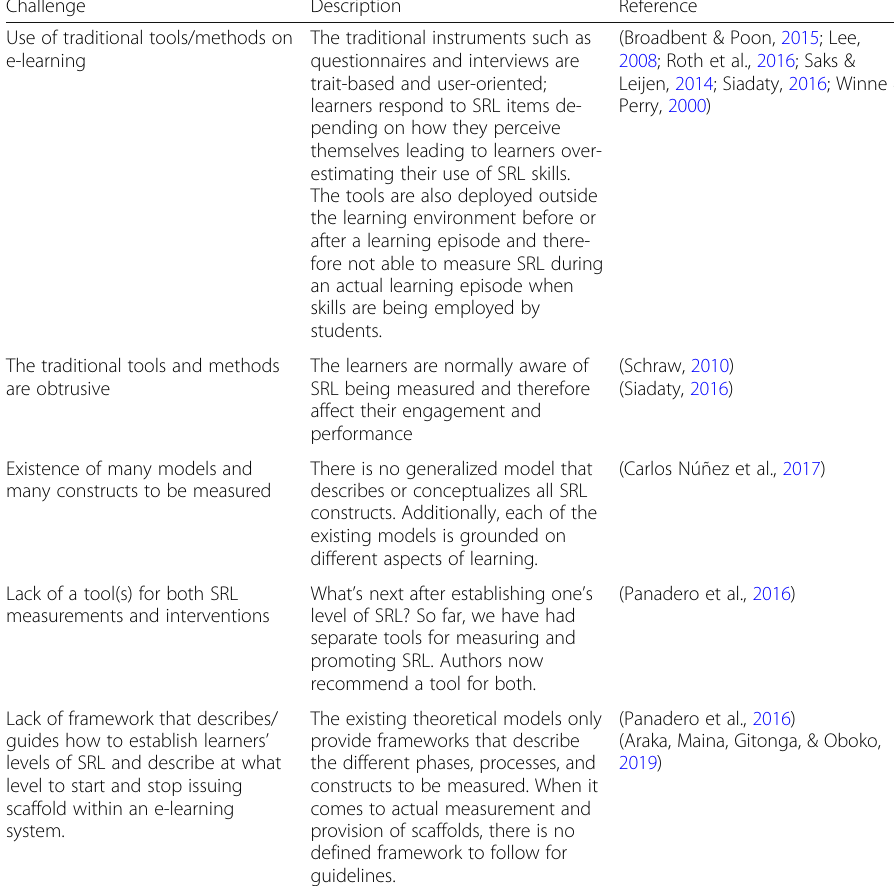
Table 3 Challenges of measuring SRL on e-learning platforms